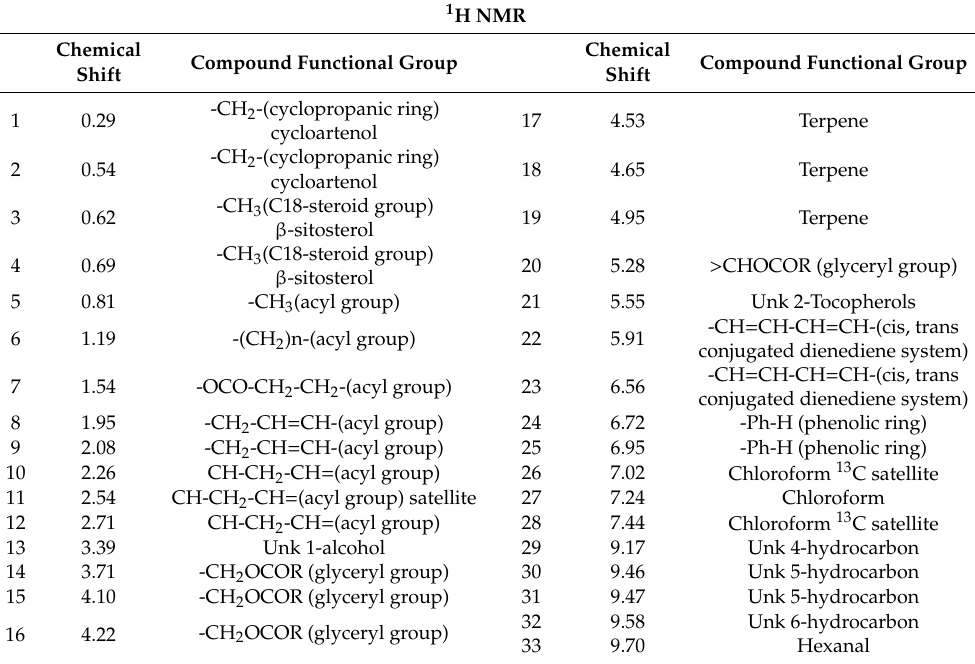
Table 1. Chemical shifts and the corresponding chemical functional group observed for 1 H NMR.